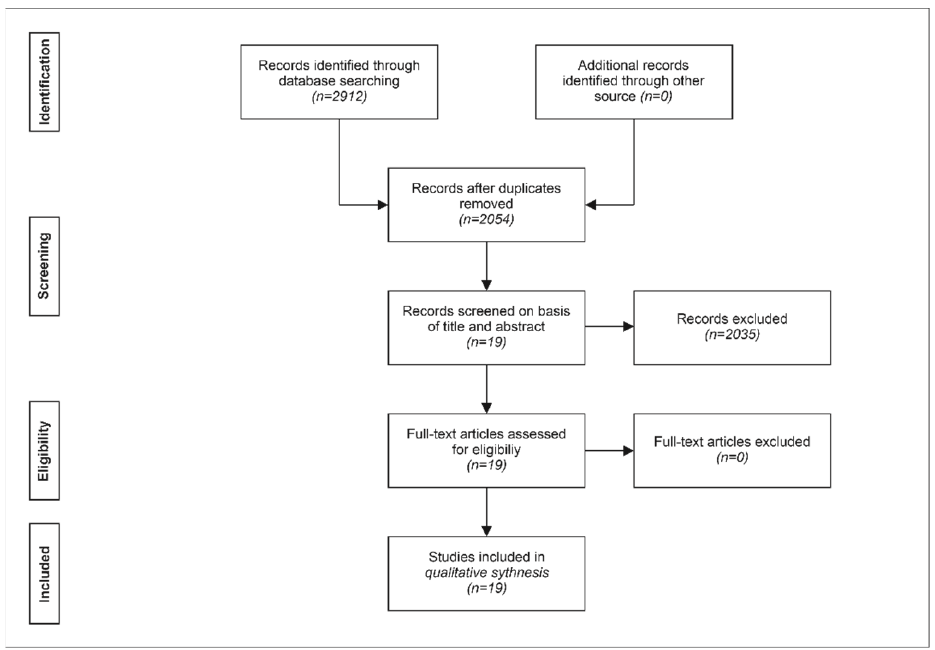
Figure 1. Systematic review flow chart of the first literature search regarding meta-analyses of clinical studies on the treatment of primary knee osteoarthritis with stem cells that were published between January 2020 and July 2021, performed according to the PRISMA guidelines [198] on 7 August 2021.